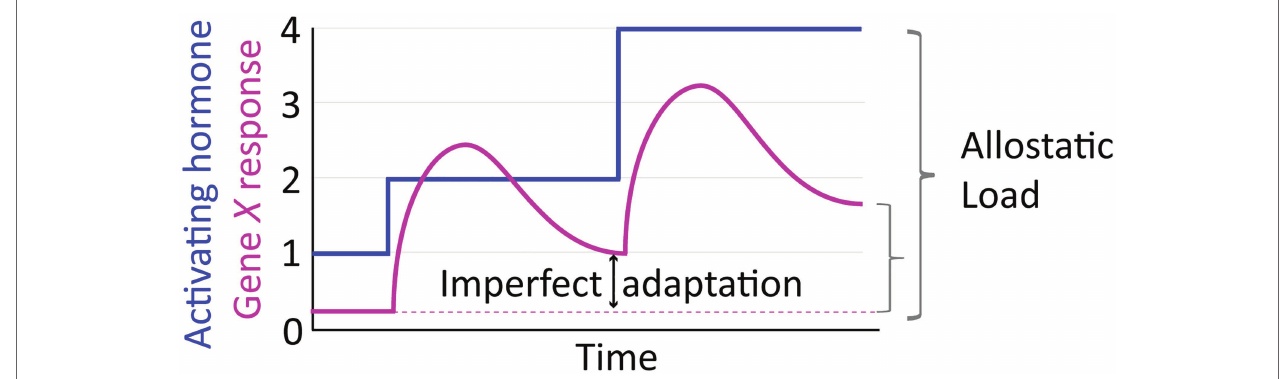
FIGURE 4 | The allostatic load concept illustrated in relation to an idealized depiction of transcriptional response dynamics manifesting imperfect adaptation to stepwise increases in activating